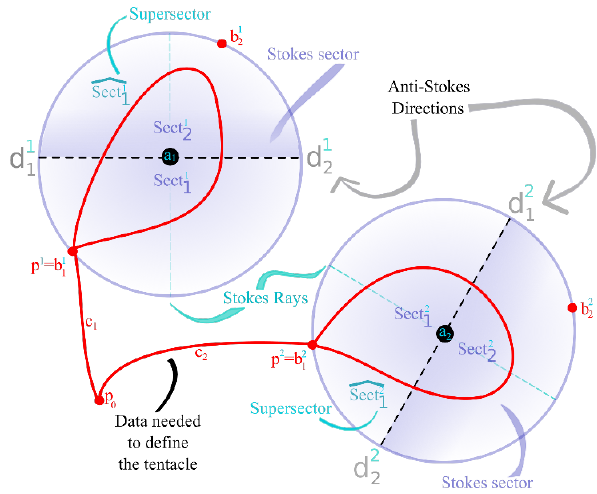
Figure 6 . Tentacles for two poles of order